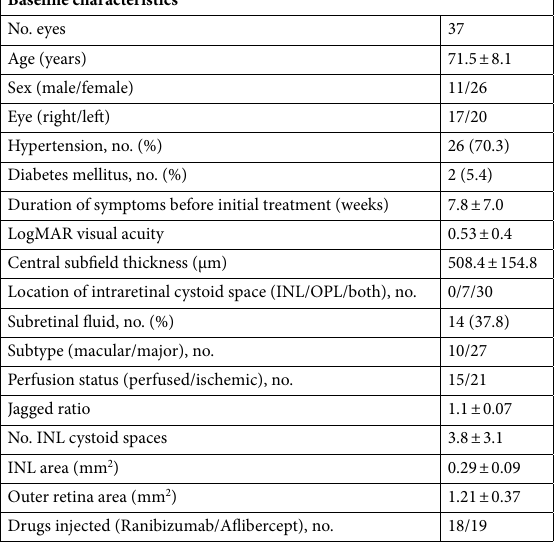
Table 1. Patient characteristics and optical coherence tomography findings at the initial visit. Fluorescein angiography was not performed in 1 eye. The data are expressed as the mean ± standard deviation. INL inner nuclear layer, logMAR logarithm of the minimum angle of resolution, No. number, OPL outer plexiform